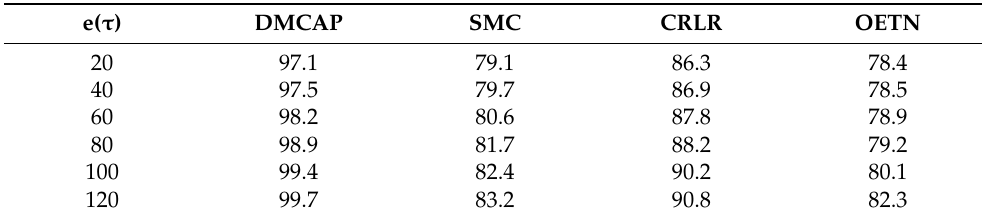
Table 5. Reactive link establishment rate